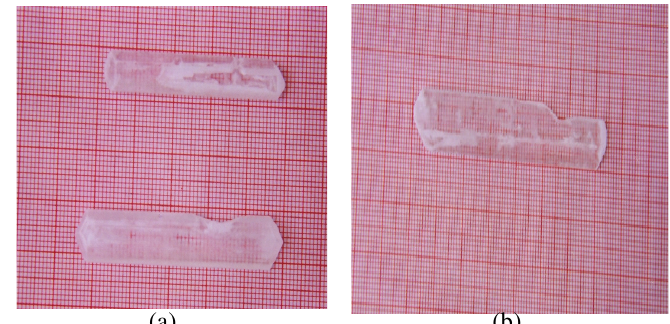
Figure 5. (a)&(b) As- grown crystals of ZSHH grown by solvent evaporation method. Characterization